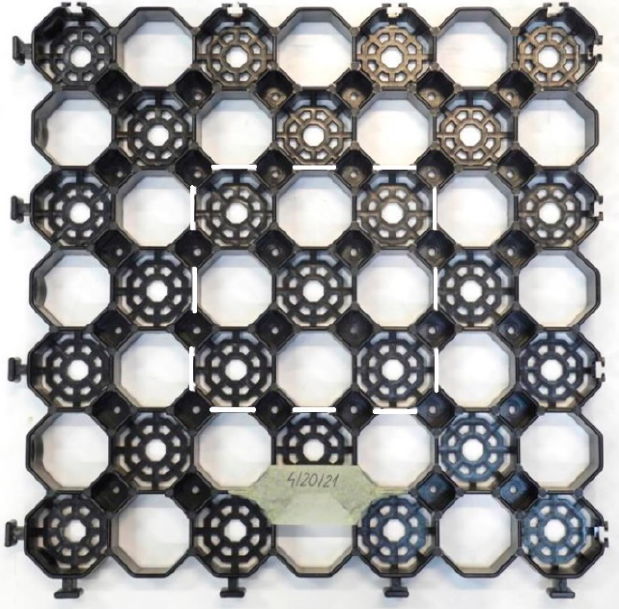
Figure 12. A picture of the geocell before the test; the position of the sample is marked with white lines; compression in the middle area.